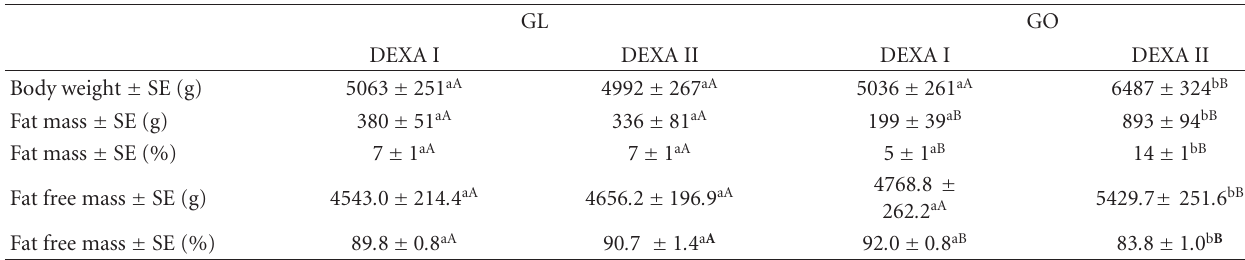
Table 2: Mean of body weight (BW), body fat mass (total (g), and (%)) fat-free body mass (total (g), and (%)) and body weight (g) of the cats of the groups GL (lean phenotype) and GO (overweight phenotype); DEXA I: first DEXA measurement before the adaptation period; DEXA II: second DEXA measurement at the end of the second phase of ad libitum feeding after four weeks of weight constancy. GL GO DEXA I DEXA II DEXA I DEXA II Body weight ± SE (g) 5063 ± 251 aA 4992 ± 267 aA 5036 ± 261 aA 6487 ± 324 bB Fat mass ± SE (g) 380 ± 51 aA 336 ± 81 aA 199 ± 39 aB 893 ± 94 bB Fat mass ± SE (%) 7 ± 1 aA 7 ± 1 aA 5 ± 1 aB 14 ± 1 bB Fat free mass ± SE (g) 4543 . 0 ± 214 . 4 aA